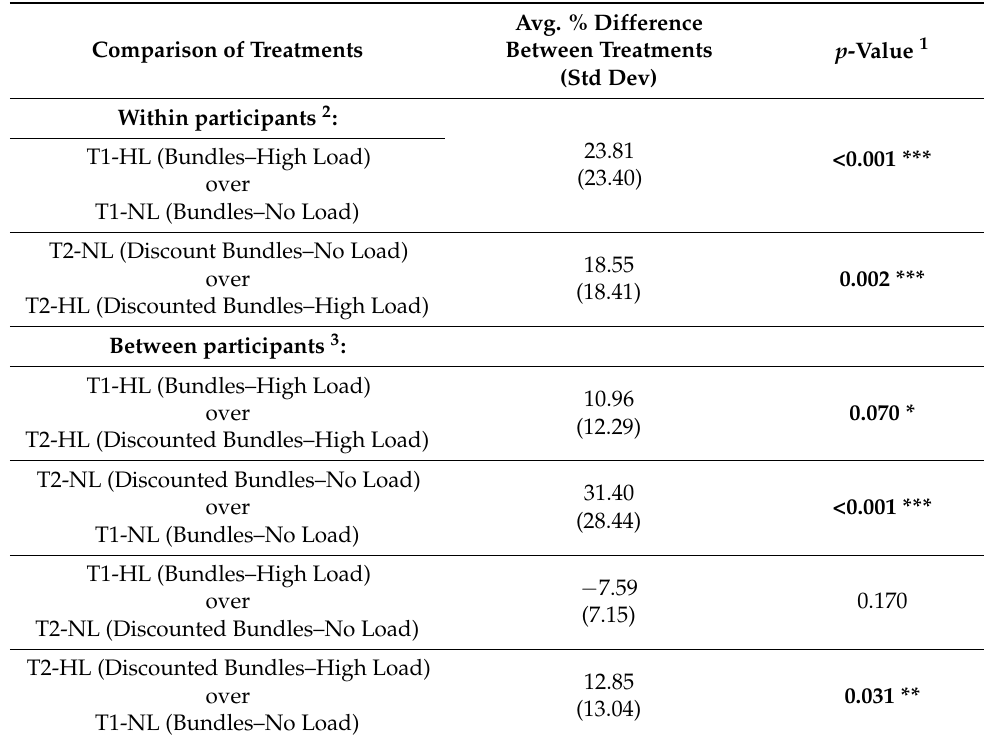
Table 5. Comparison Statistics, by Treatment, for the Percentage of Consumers Selecting Any Food